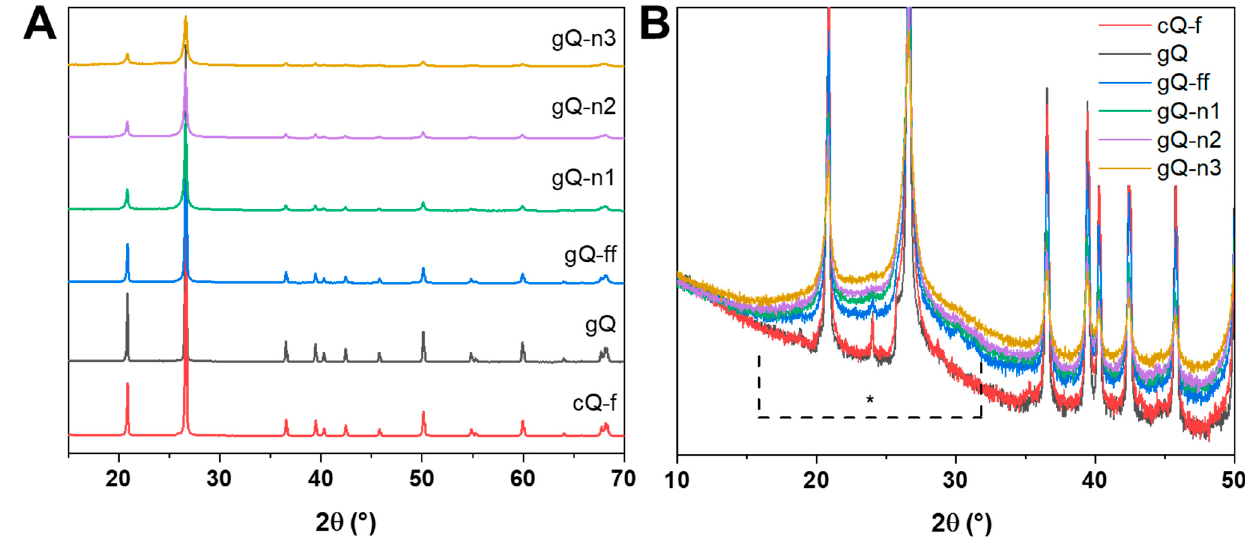
Figure 3. Crystallinity of the nanoquartz samples (gQ-n1, gQ-n2, and gQ-n3) compared with the as- grown micrometric quartz (gQ), the fine-fractured quartz (gQ-ff), and a mined fractured quartz used as reference (cQ-f). Diffractograms obtained by XRPD analysis in the 15–70° region ( A ). Magnification of the diffractograms in the 10–50° region showing the amorphous broad signal ( B ).